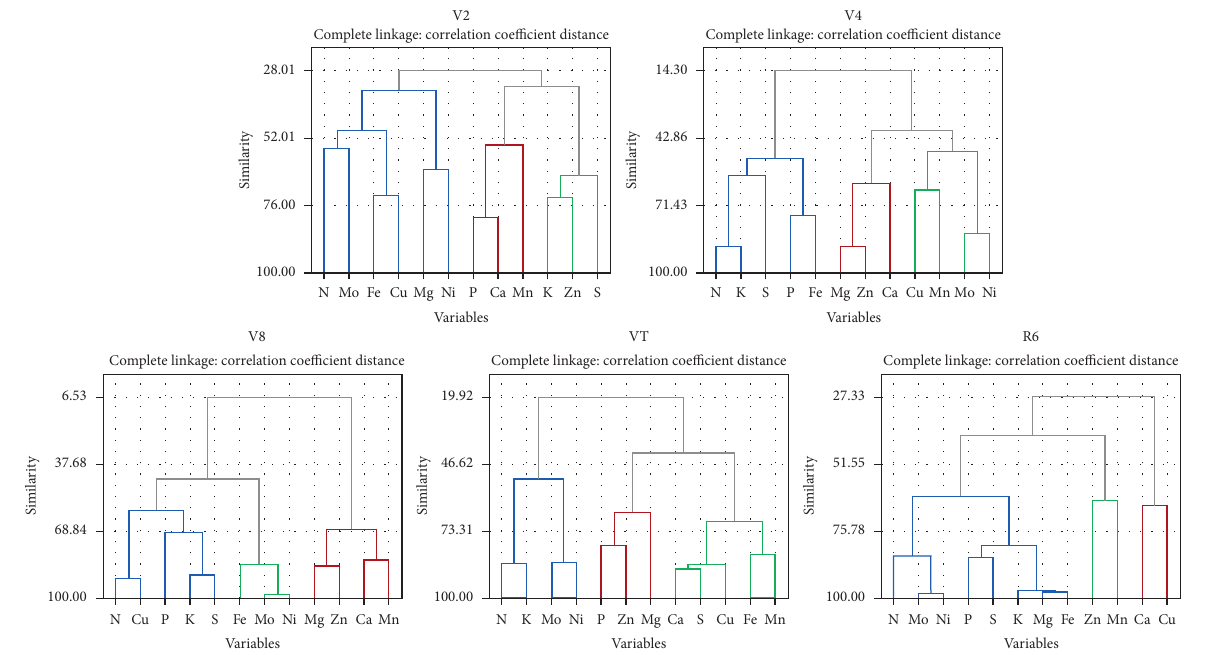
Figure 4: Cluster of sampling times in nutrients with means of NPK on stalk. Nitrogen (N), potassium (K), phosphorus (P), magnesium (Mg), calcium (Ca), sulphur (S), zinc (Zn), iron (Fe), copper (Cu), manganese (Mn), nickel (Ni), and molybdenum (Mo). AMMI analysis of stalk and